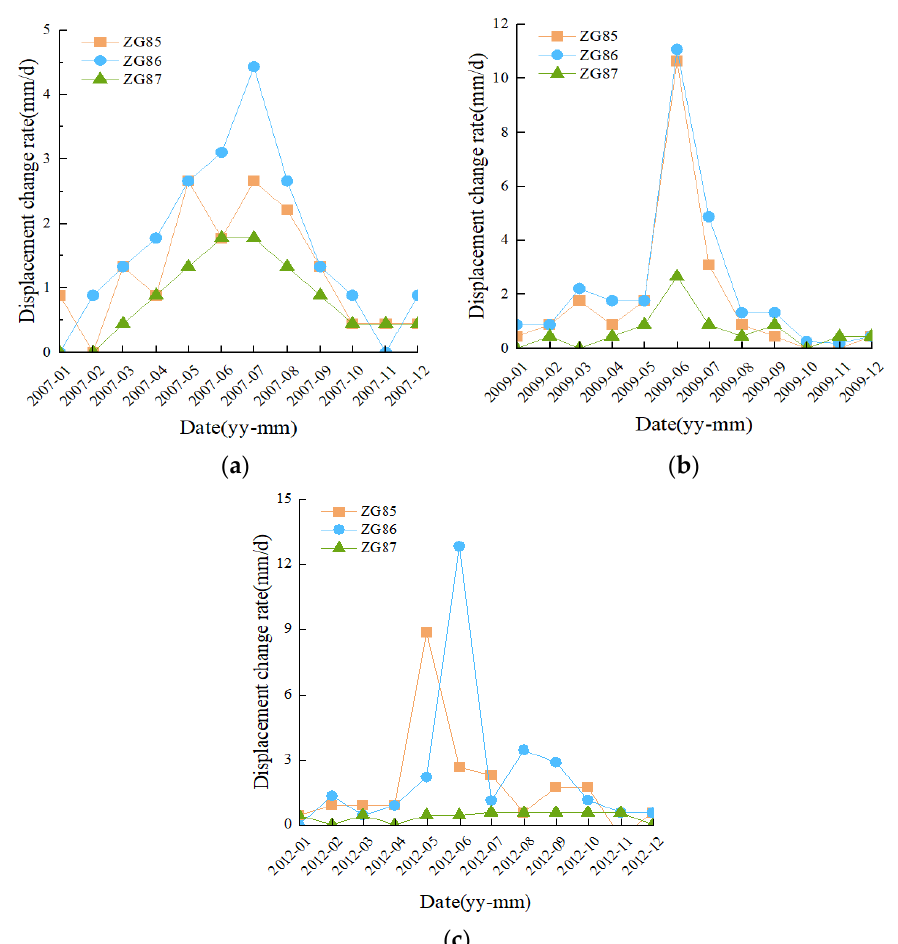
Figure 4. Daily displacement change rate at each monitoring station: ( a ) 2007; ( b ) 2009; ( c ) 2012.